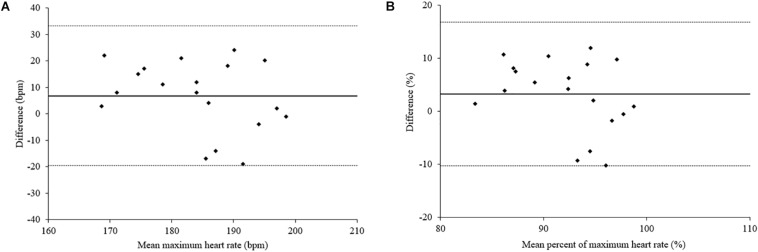
Bland–Altman plot showing individual differences between (A) maximum heart rate (HRmax) and (B) percent of maximum heart rate (HRmax%) during CPET versus the MST. The solid line indicates the mean difference between paired measurements and the dotted lines indicate the 95% limits of agreement.